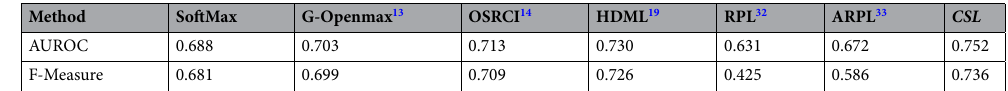
Table 2. The results of open-set skin disease identification on ISIC-open